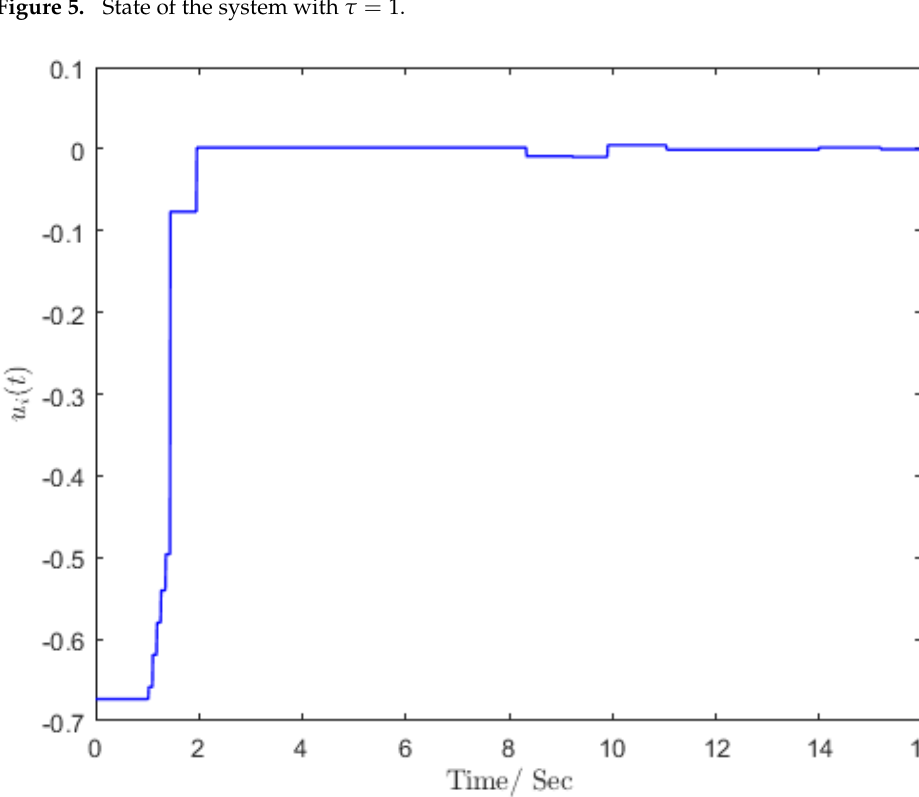
Figure 5. State of the system with τ = 1.